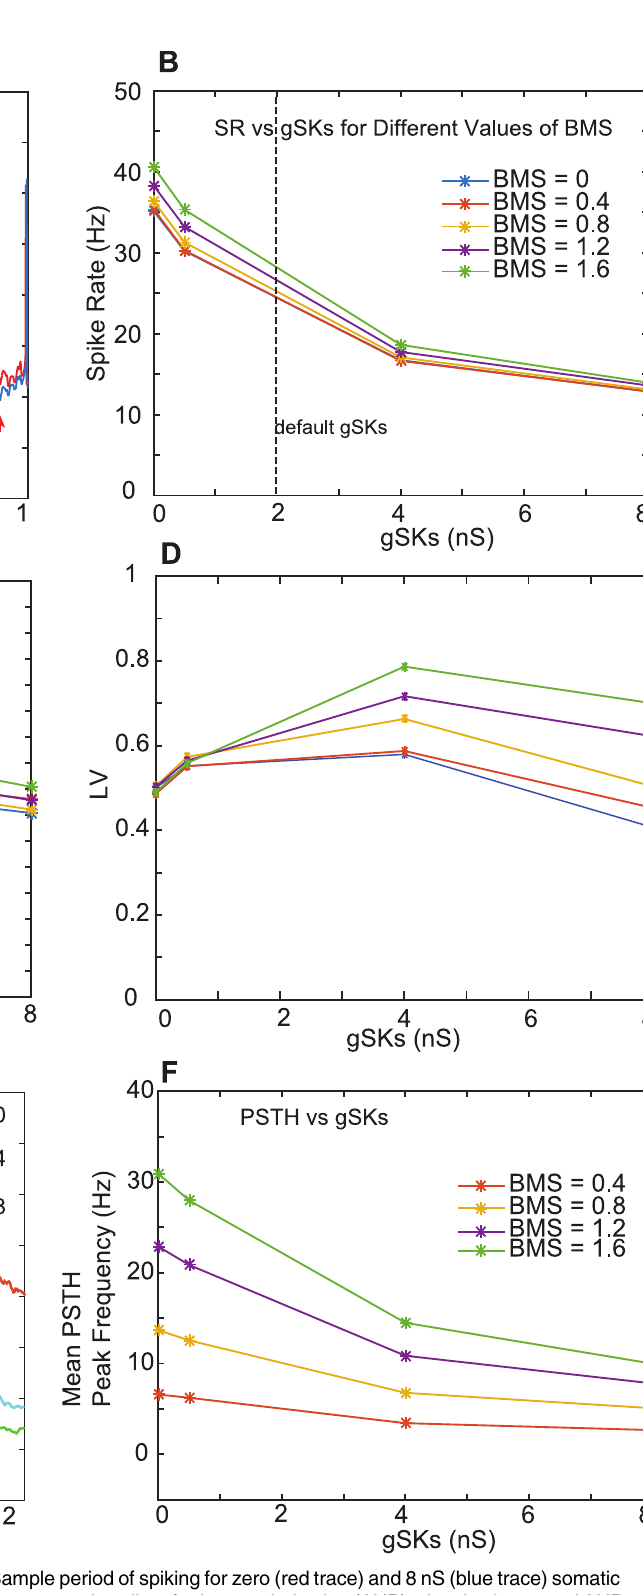
PLOS Computational Biology | https://doi.org/10.1371/journal.pcbi.1005578 June 15,